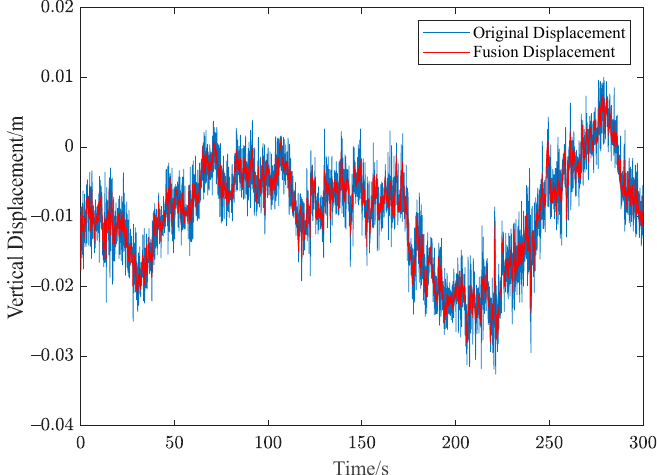
Figure 4. Suntuan River Bridge vertical displacement before and after GNSS/acceleration fusion.